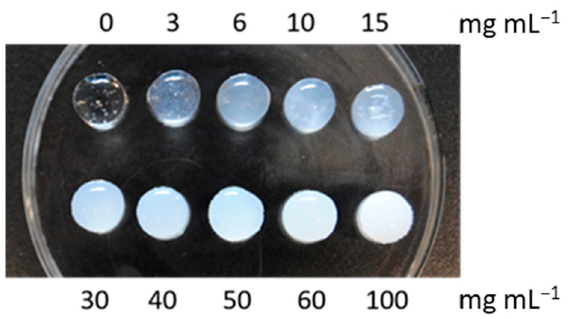
Figure 4. Hyaluronic acid gels (0.5 mL) with different concentrations of calcined mesoporous silica nanoparticles. The HA-based gels were able to tolerate very high loading of nanoparticles (up to 100 mg mL − 1 ).